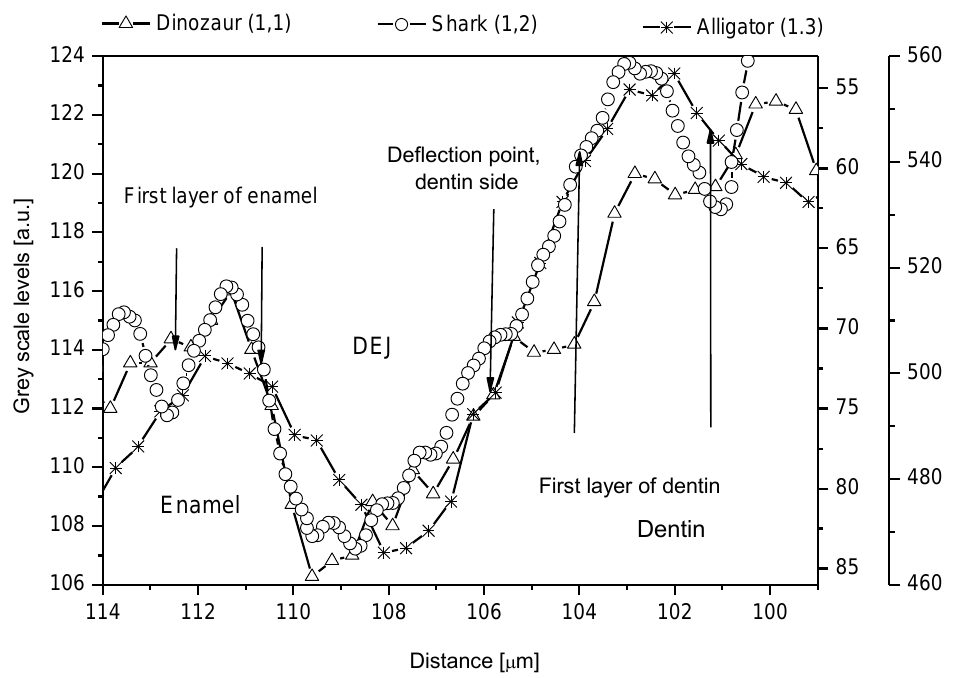
Figure 9. Outline of the DEJ zone for an unidentified American dinosaur, a shark, and an alligator. It seems that the strict determination of size, structure, and role of the DEJ can help in synthesis of the next generation of smart dental restorative materials, the internal structure of which would be tailored to the natural chemical and mechanical properties of each part of the tooth. A part of the recent failures should be ascribed to the inconsistency of fillings with the remaining tissue. This worsens the adherence of the new material to the original tissues. In addition, it gives catastrophic effects in the case of great mechanical stresses. Lastly, one should remember that the energetic status of apatite crystals in different locations is significantly different, as shown for the first